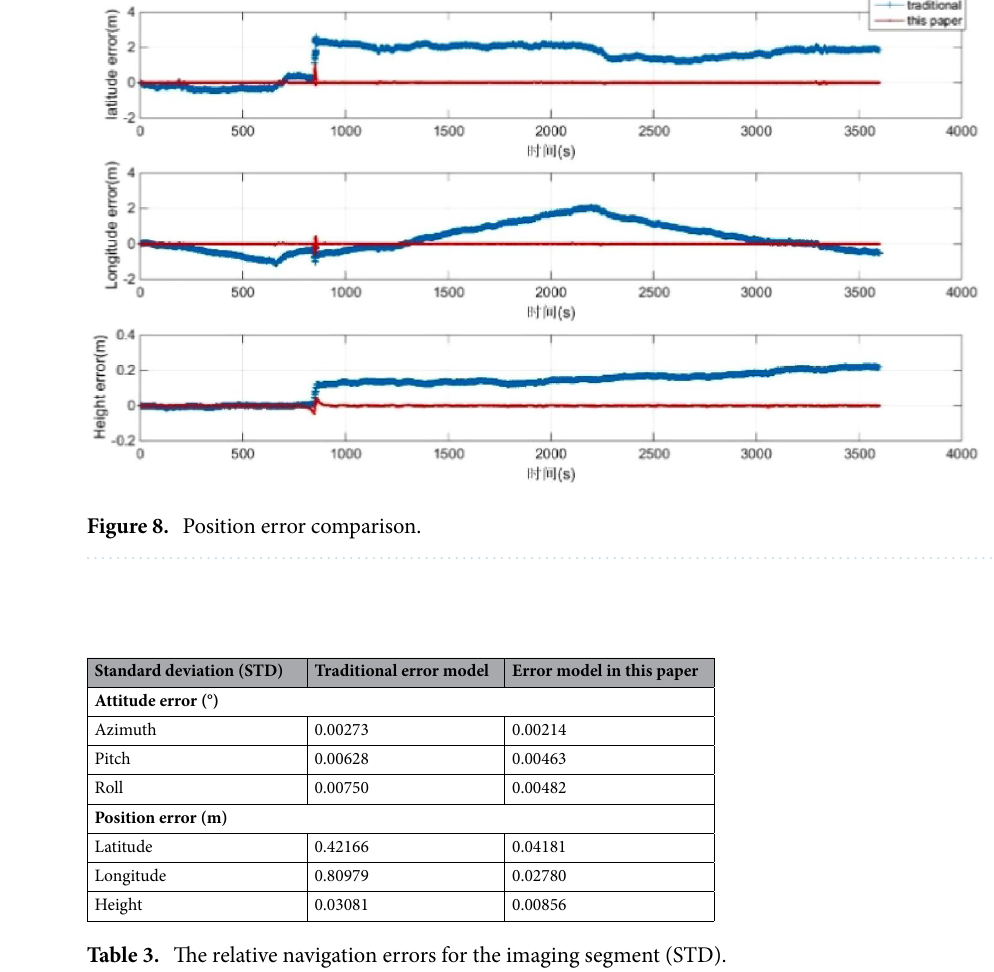
Table 3. The relative navigation errors for the imaging segment